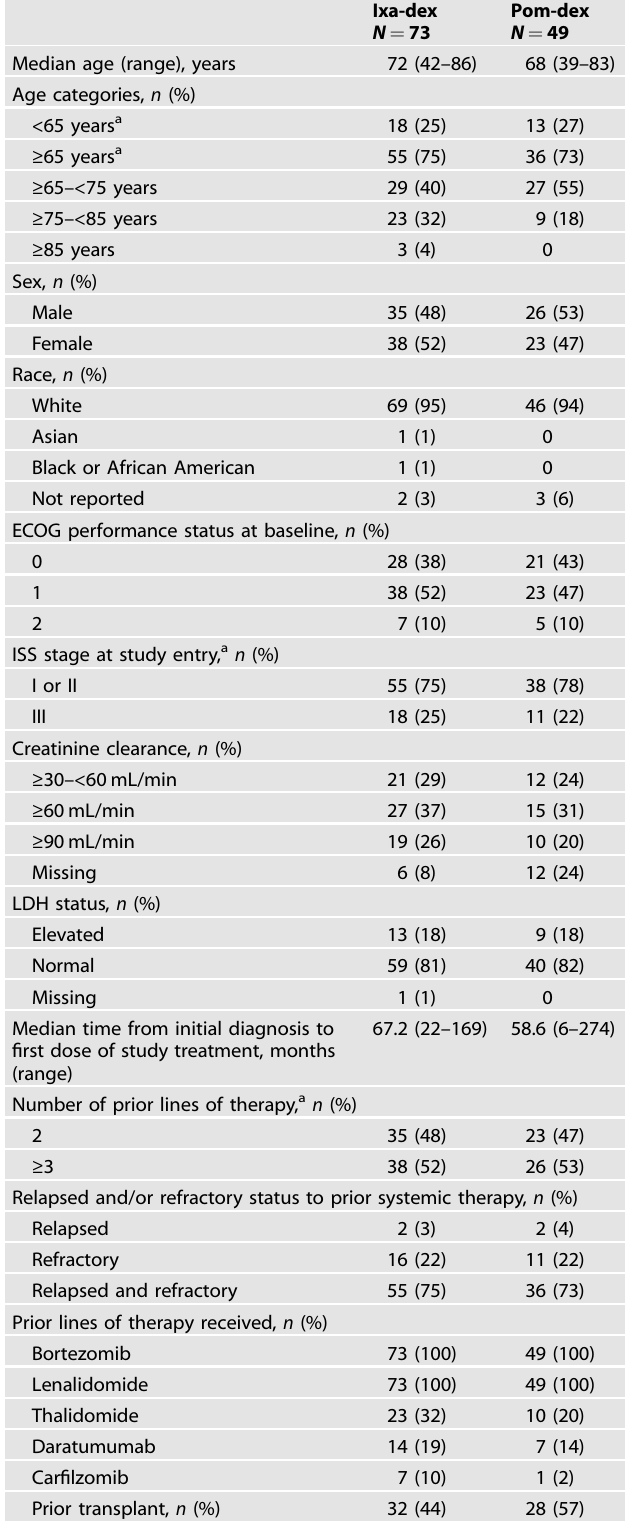
Table 1. Patient demographics and baseline disease